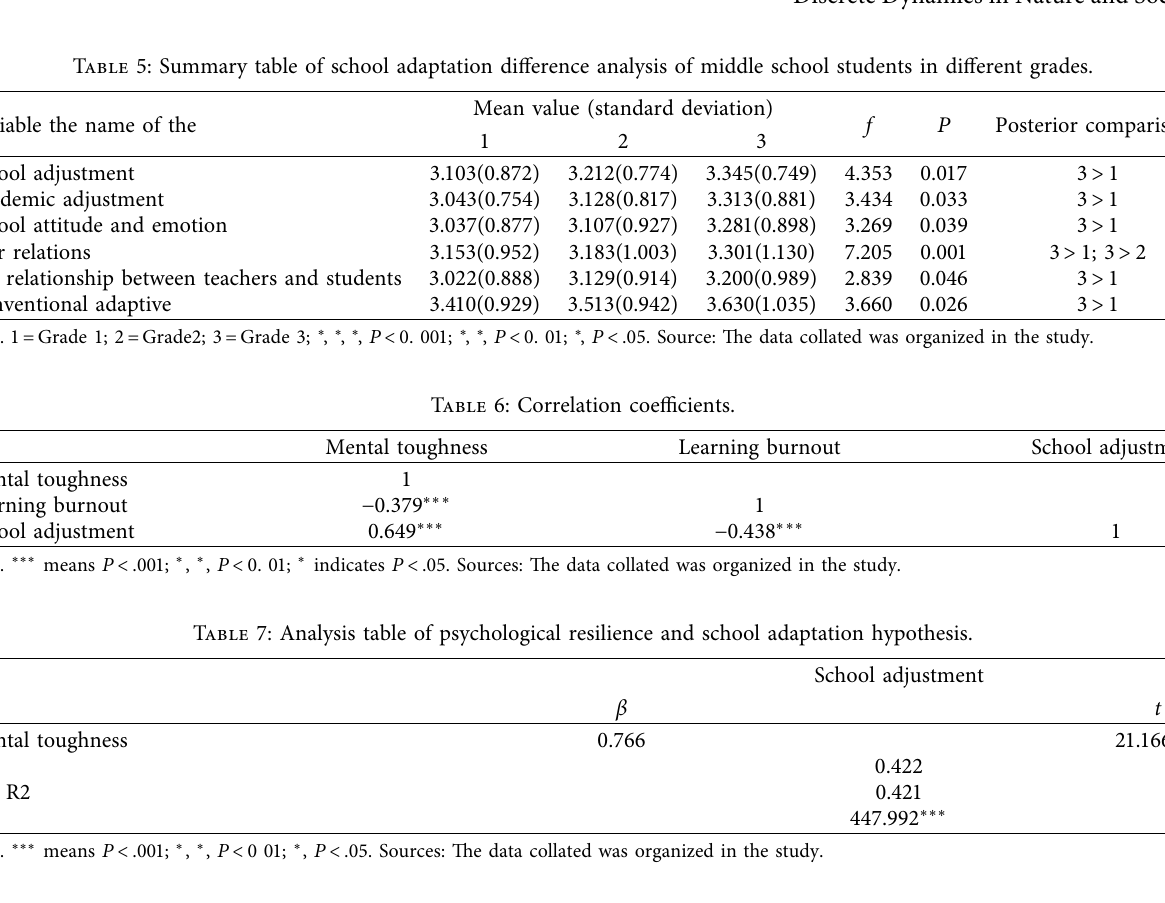
Table 8: Hypothesis analysis of mental toughness and learning burnout.